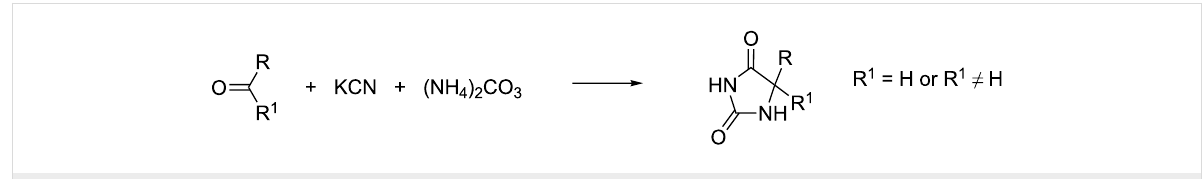
Scheme 42: The three-component Bucherer–Bergs reaction.